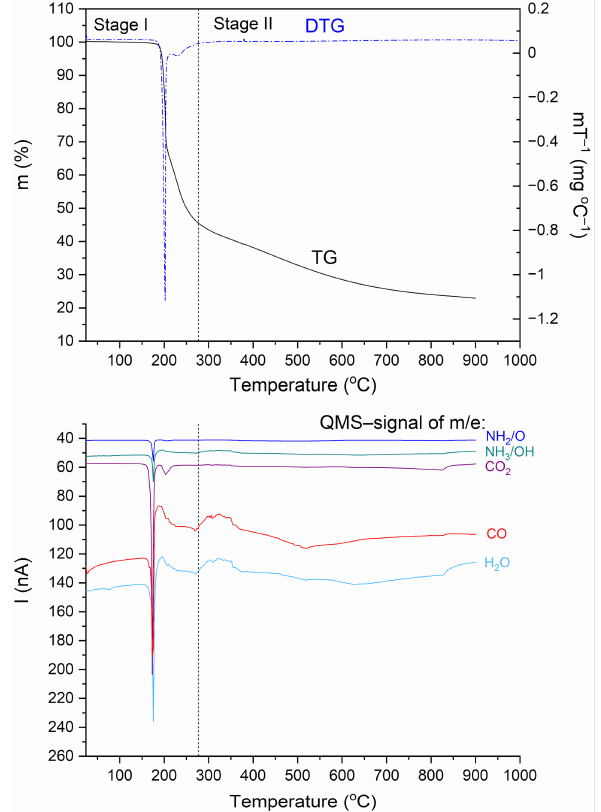
Figure 6. TG, DTG, and QMS curves for the N,N-dimethylglycine–chloranilic acid complex registered at a heating rate of 10 ◦ C min − 1 in the temperature range of 25–900 ◦